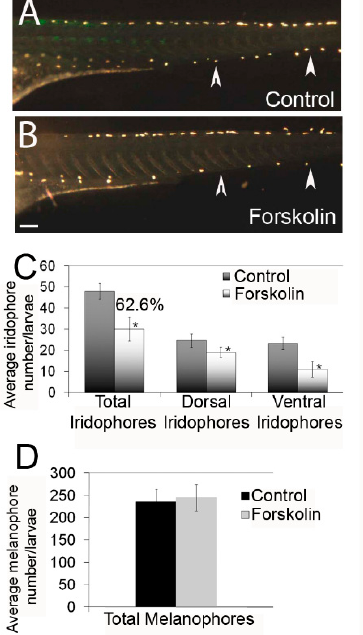
Figure 1. Forskolin treatment reduces iridophore number in zebrafish larvae at 4 days post fertilization (dpf). ( A , B ) Lateral images (using an incident lighting source) of larvae at 4 dpf treated with 0.1% dimethyl sulfoxide (DMSO) or 5 µM forskolin in embryo media. Forskolin-treated individuals have fewer iridophores, especially in the ventral stripe (arrowheads). Scale bar = 200 um and applies to panels A and BC) Quantification of total, dorsal stripe, and ventral stripe iridophores ( n = 8–10 larvae per condition). Forskolin treatment leads to a 38.4% reduction in differentiated iridophores (62.6% of control number). ( D ) Quantification of melanophores following 0.1% DMSO or 5 µ M forskolin treatment. Total melanophores include dorsal, lateral, and ventral stripes ( n = 8–10 larvae per condition), showing no significant change following forskolin